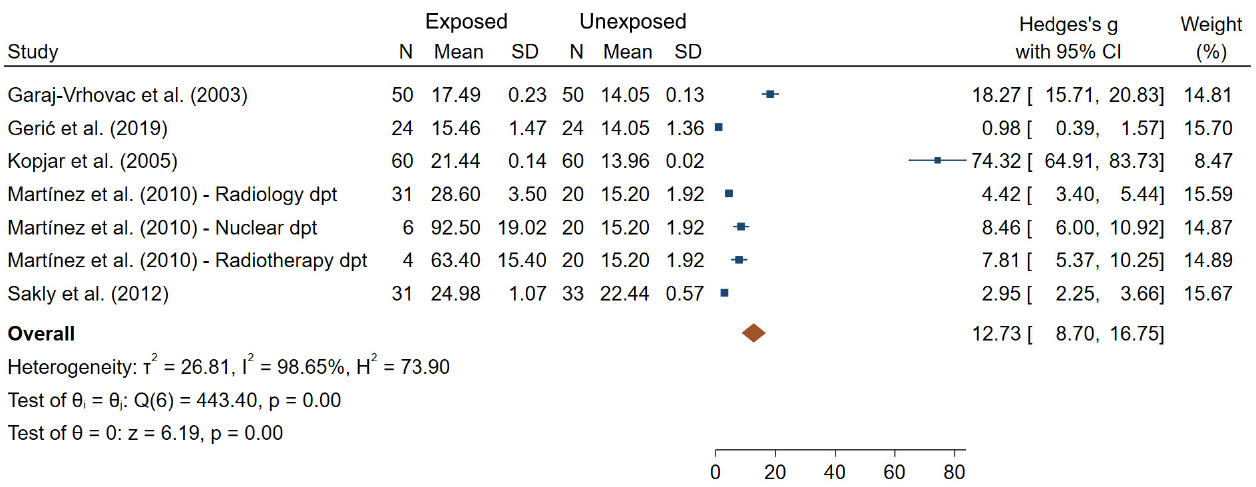
Figure 8. Forest plot of mean differences in tail length between IR exposed and unexposed workers.